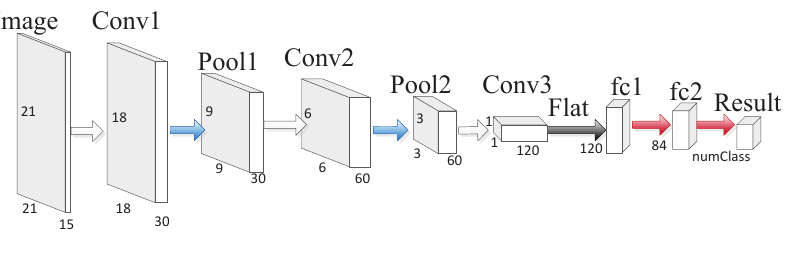
Figure 6. The architecture of CNN, where image represents the input image, Conv denotes the convolutional layer, Pool denotes the max pooling layer, flat denotes the flat operation, fc denotes the full connected layer, and Result denotes the classification